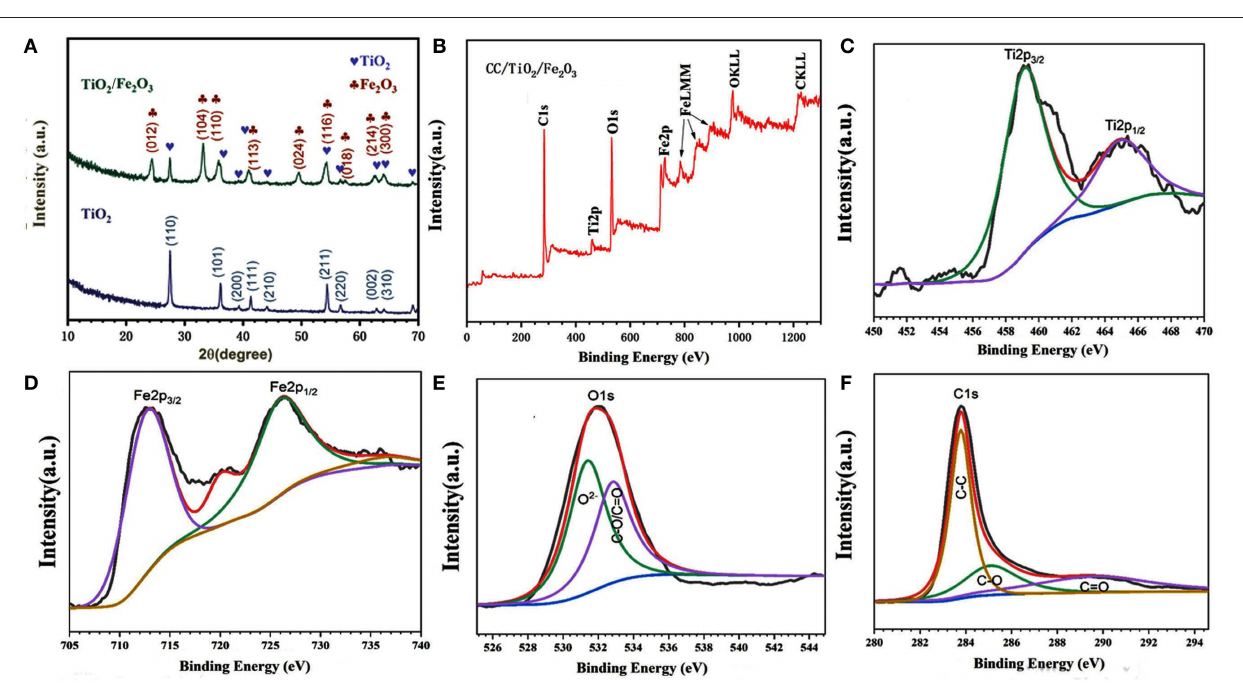
FIGURE 1 | (A) XRD pattern of CC/TiO 2 and CC/TiO 2 /Fe 2 O 3 hollow nano-arrays. XPS spectra of CC/TiO 2 /Fe 2 O 3 specimens. (B) Survey spectra. (C) Ti2p core-level spectra, (D) Fe2p core-level spectra. (E) O1s core-level spectra, and (F) C1s core-level